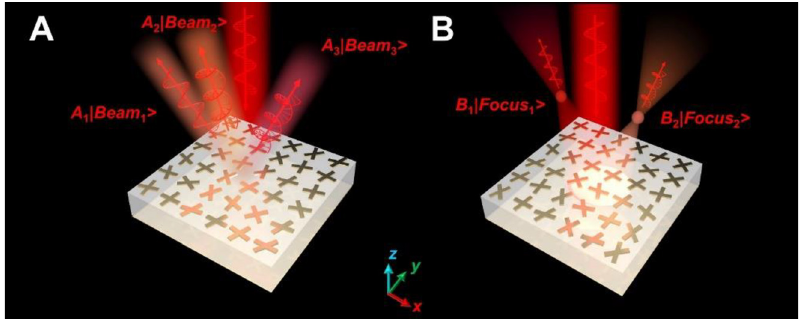
Figure 1: Schematic of the proposed reflective metasurface with arbitrary and independent control of spatial and powers of the wavefront under normal CP wave excitation. (A) The reflective beams with independent and distinct powers can be controlled to arbitrary directions. (B) Two- foci with different powers generated by the